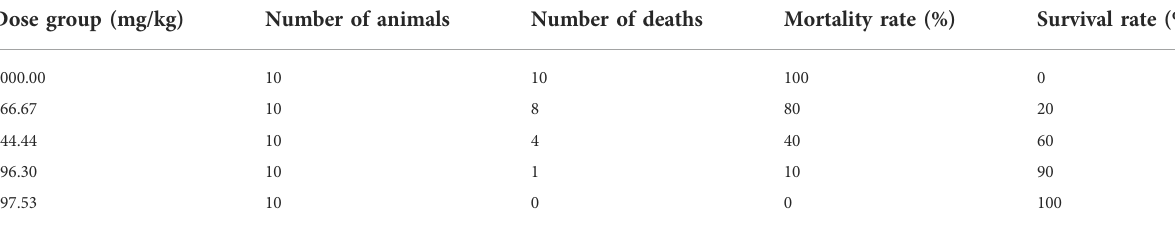
TABLE 1 Oral acute toxicity of MPTA to mice (n =